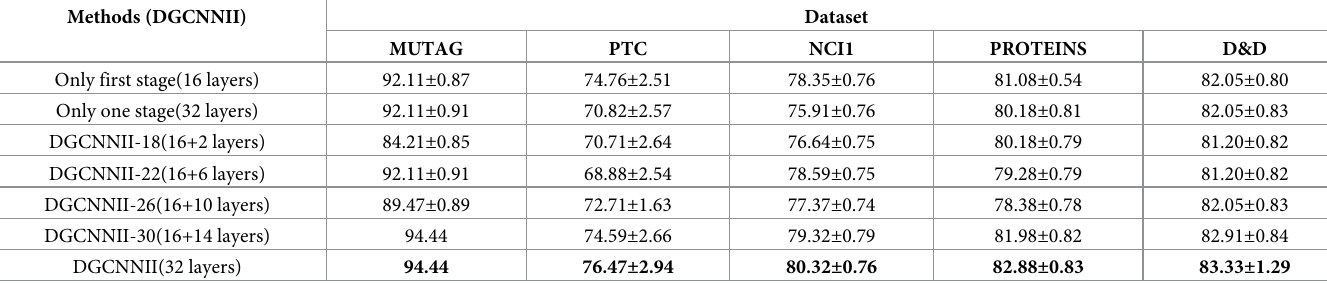
Table 7. Experimental results of ablation study of DGCNNII